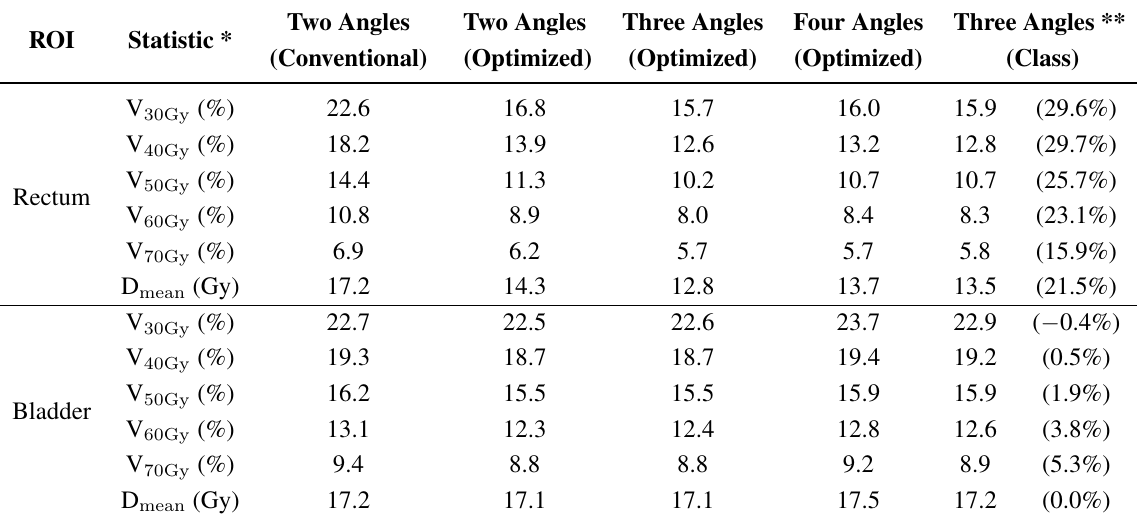
Table 1. Dose volume data for IMPT plans with different beam angle arrangements in average by three prostate cancer patients.